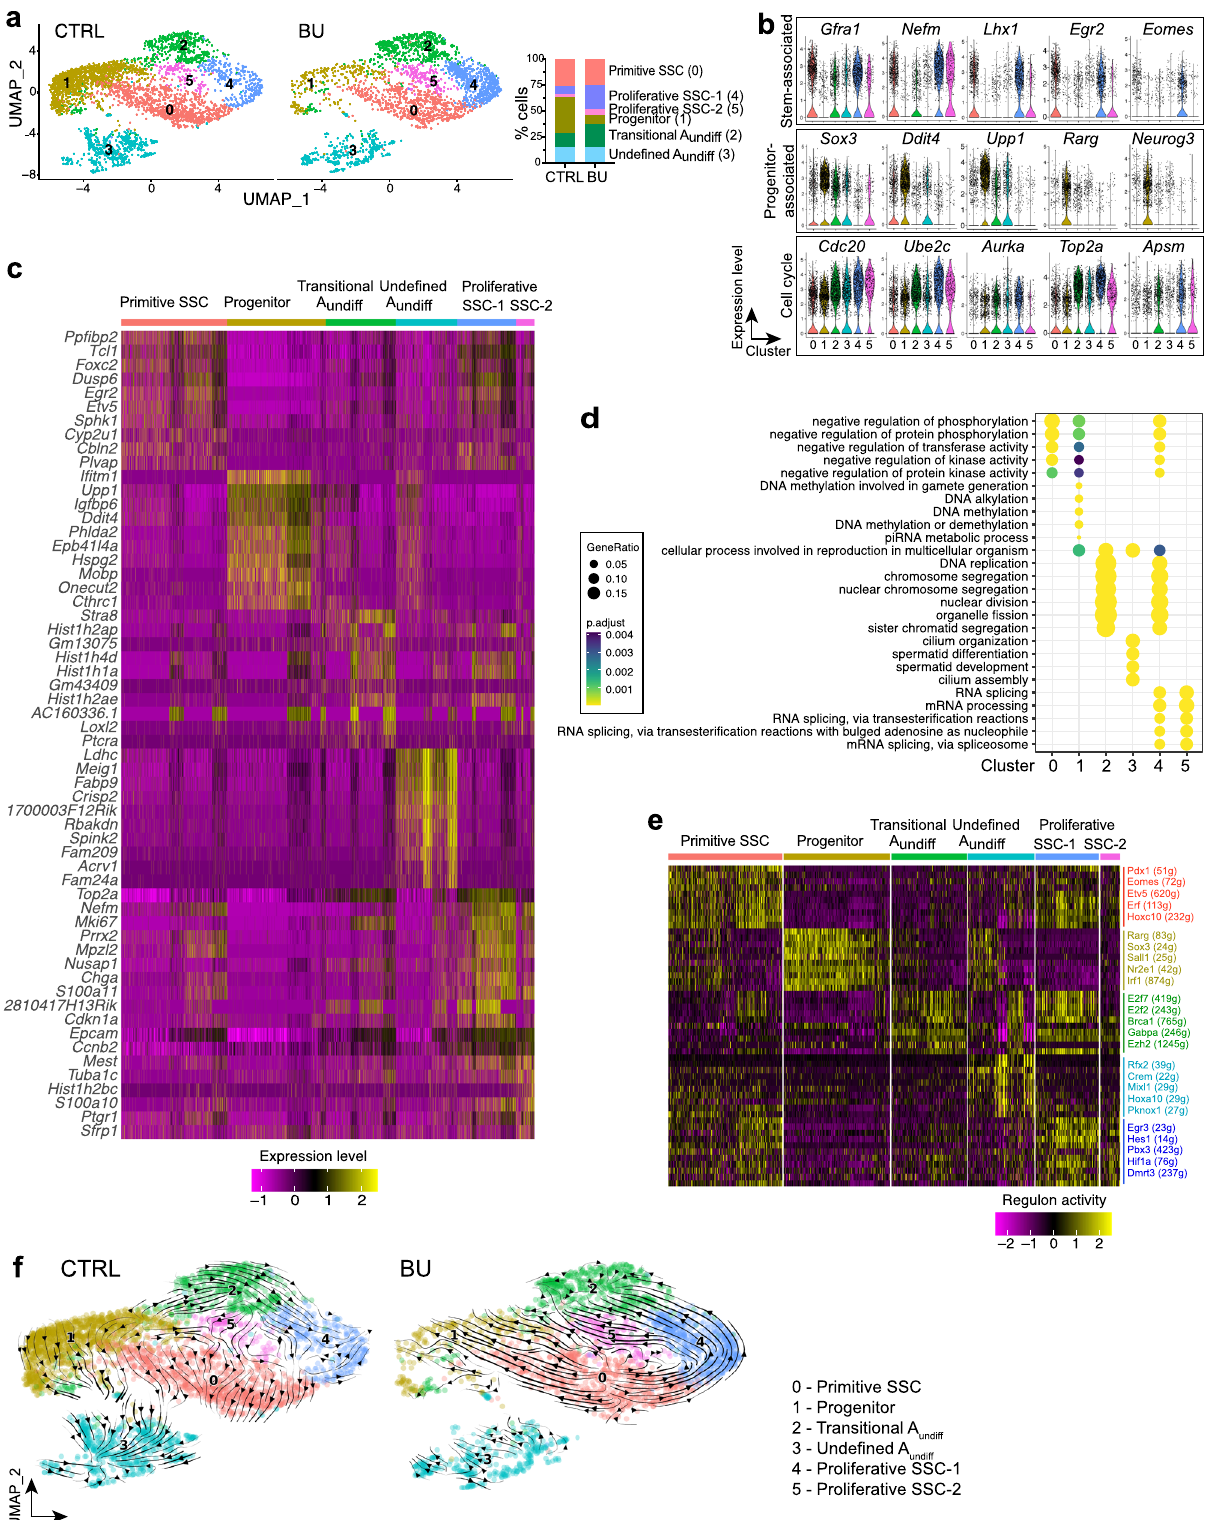
and function can be affected by proximity to sources of growth factors 2,19 , these clusters may represent SSCs from different cycle stages and/or distinct locations within the seminiferous tubule. To gain insight into identity of A undiff clusters and associated regulatory mechanisms, we analysed gene regulatory networks using SCENIC, which calculates activity of